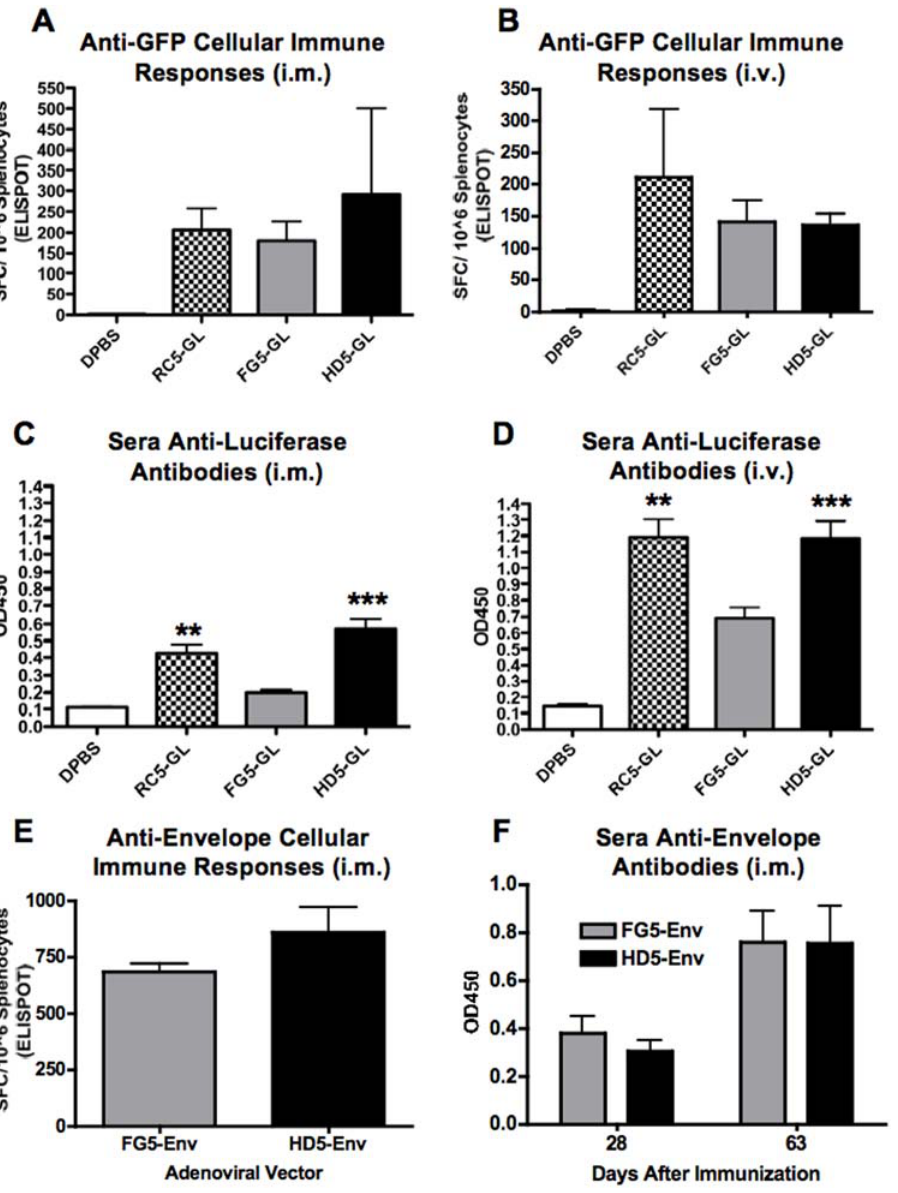
Figure 3. Humoral and cellular immune responses. Vector induced humoral and cellular immune responses against the transgene products were quantitated. Anti-GFP cellular immune responses induced by i.m. (A) and i.v. (B) injection are shown as IFN- c spot forming cells (SFC) as measured by ELISPOT of splenocytes 4 weeks after immunization. Splenocytes were pulsed with H-2K d -restricted GFP peptide. Data is the mean from 5 mice for each group and error bars indicate standard error. Anti-luciferase antibody responses in sera from the i.m (C) and i.v. (D) immunized mice were collected 4 weeks after injection and were assayed by ELISA. Cellular and antibody immune responses against the HIV-1 envelope transgene are shown were quantitated after i.m. immunization with FG and HD vectors (E and F, respectively). Data is the mean ELISA OD450 from 5 mice for each group and error bars indicate standard error. The data were analyzed by unpaired two-tailed TTEST (**=p , 0.01 and ***=p , 0.001).